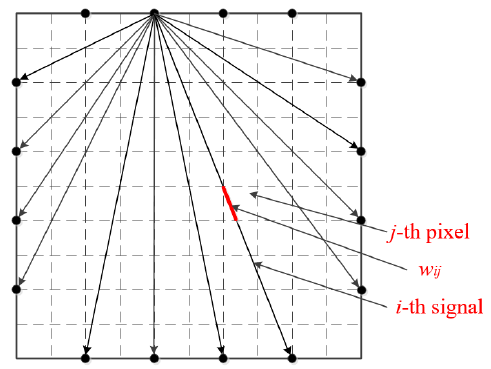
Figure 3. ART algorithm application diagram.